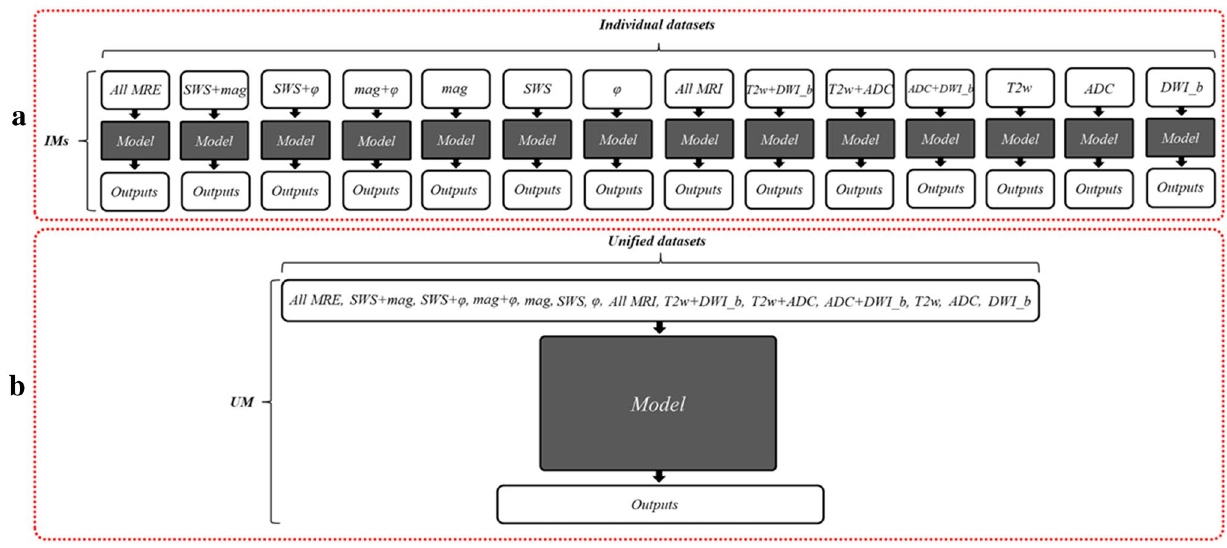
Figure 4. Diagrams of the two approaches investigated in this study. ( a ) individual models (IMs), and ( b ) unified model (UM). The figure shows all 14 input combinations used individually as separate datasets in IMs and combined into a single large dataset for training of the UM. The gray box with the ‘Model’ refers to the Dense U-net used in this study, as detailed in Fig.